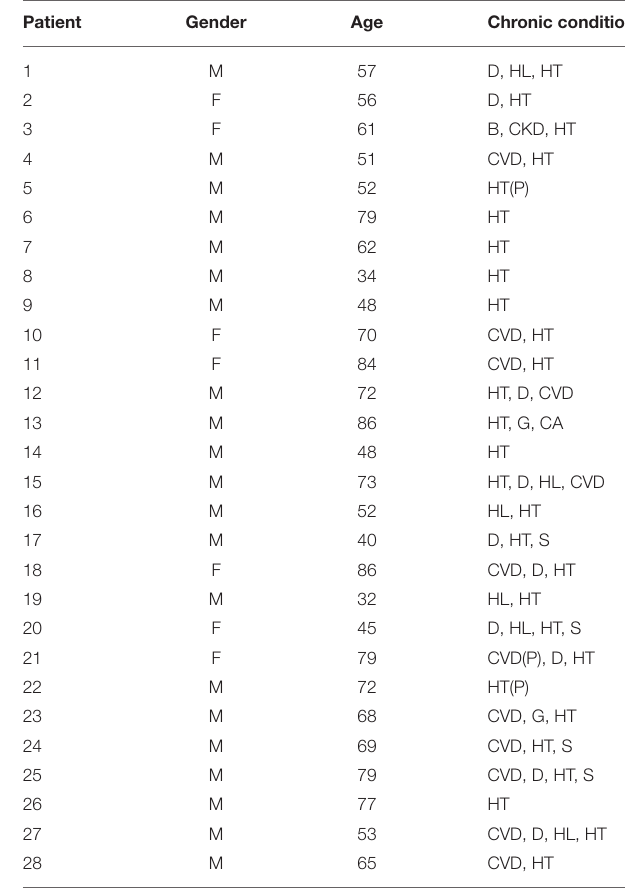
TABLE 1 | Patients’ demographic characteristics. TABLE 2 | Details about patients’ chronic